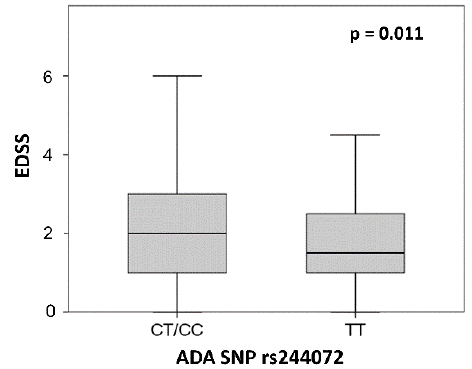
Figure 2. ADA SNP rs244072 and EDSS. EDSS score according to SNP rs244072 genotype (CT/CC vs.